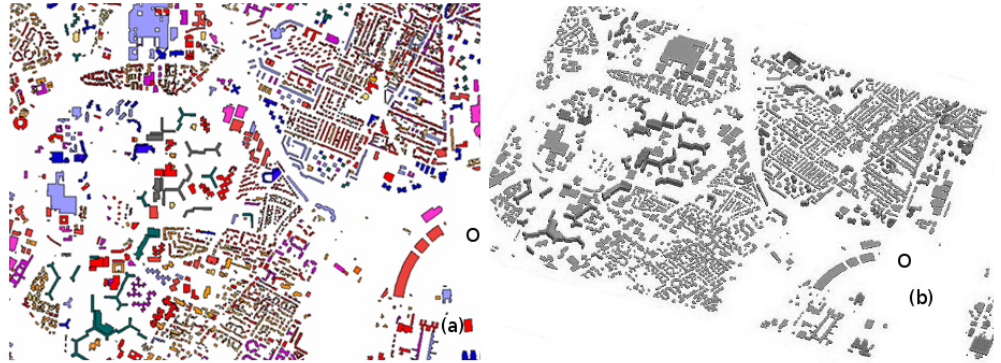
Figure 2. ( a ) IGN-BDTOPO database related to the bounded area in Figure 1: Yellow–orange–red colours represent buildings of 5–10 m height, purple–blue 10–20 m, and green-grey 30–60 m. ( b ) Recovery of the fluid–solid interface in the MNH-IBM domain modelled by the zero value of the LevelSet function. The black circle indicates the location of the factory in the two pictures. Figure 1’s legend informs about the space